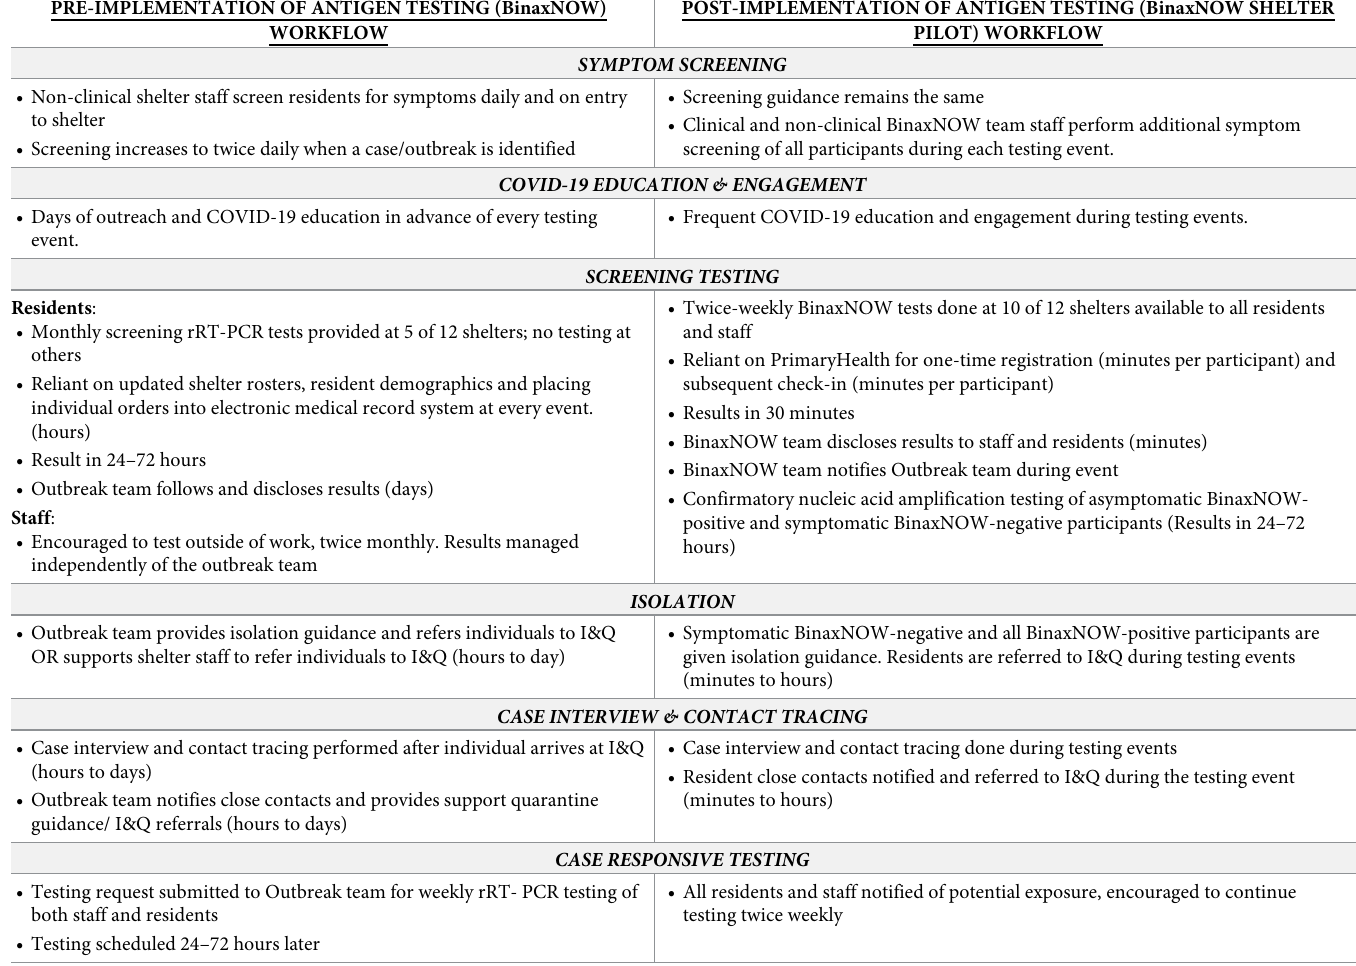
Table 1. Workflow comparisons pre- and post-implementation of rapid SARS-CoV2 antigen testing at homeless shelters, San Francisco, 2021. PRE-IMPLEMENTATION OF ANTIGEN TESTING (BinaxNOW)